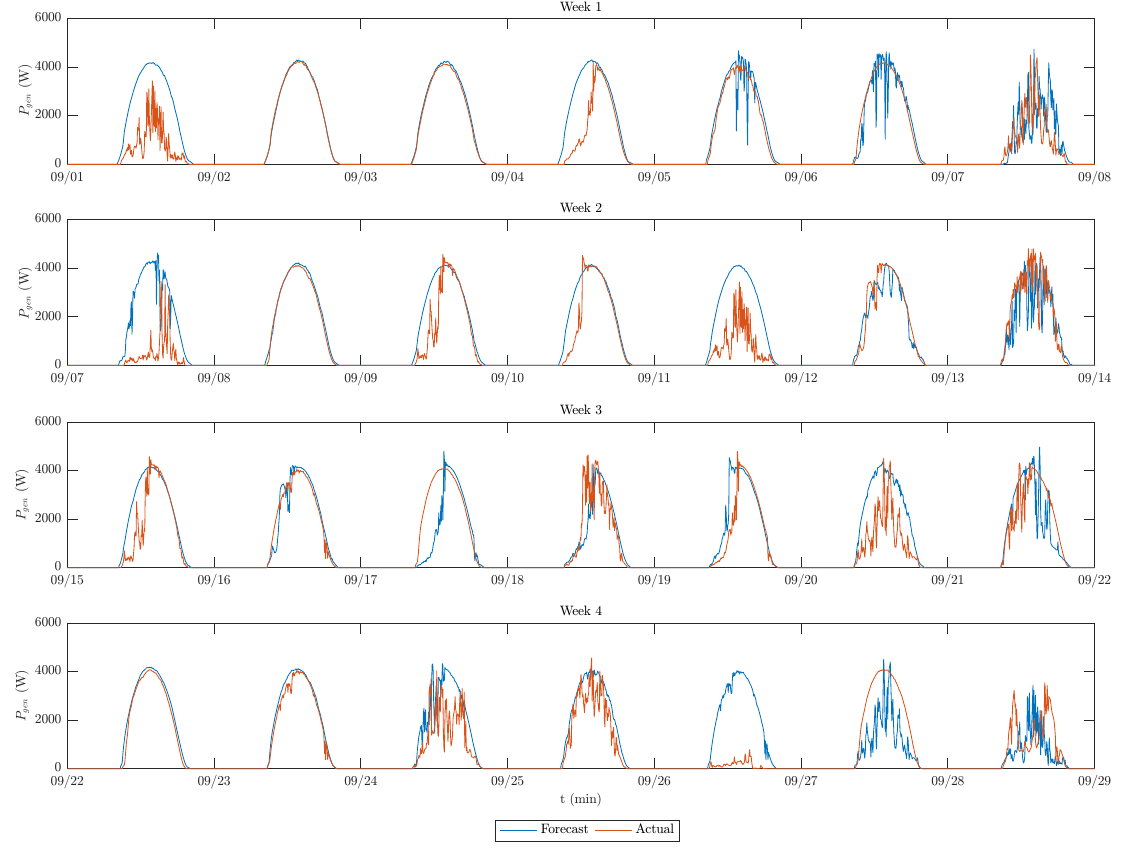
Figure 4. Forecast vs. actual PhV power generation profiles for each